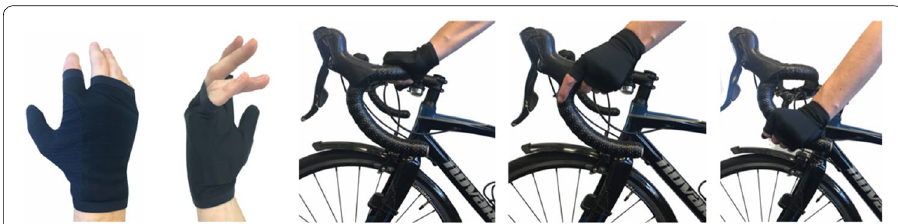
Fig. 20 Cycling glove fit and validation (Sokolowski and Hoegsted